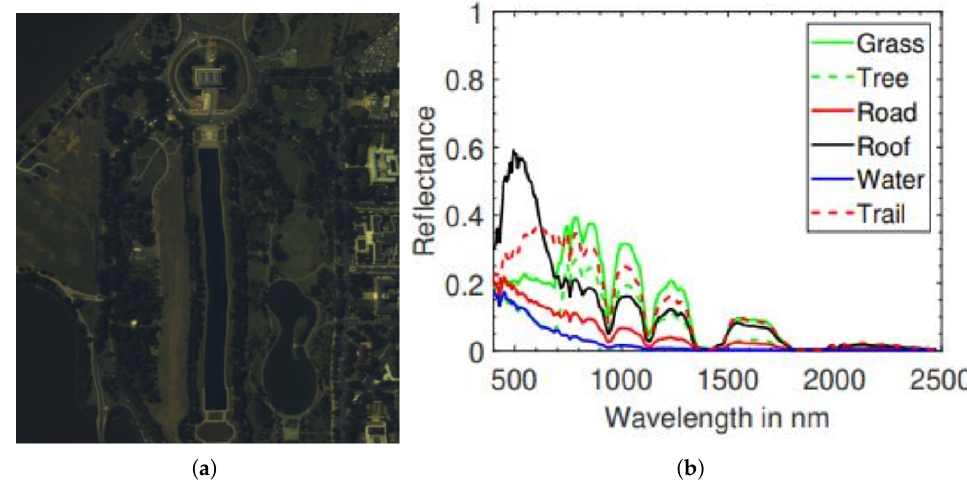
Figure 6. WDC image: ( a ) WDC color image (Red: 572.7 nm, Green: 530.1 nm, Blue: 425.0 nm) ( b ) Ground truth